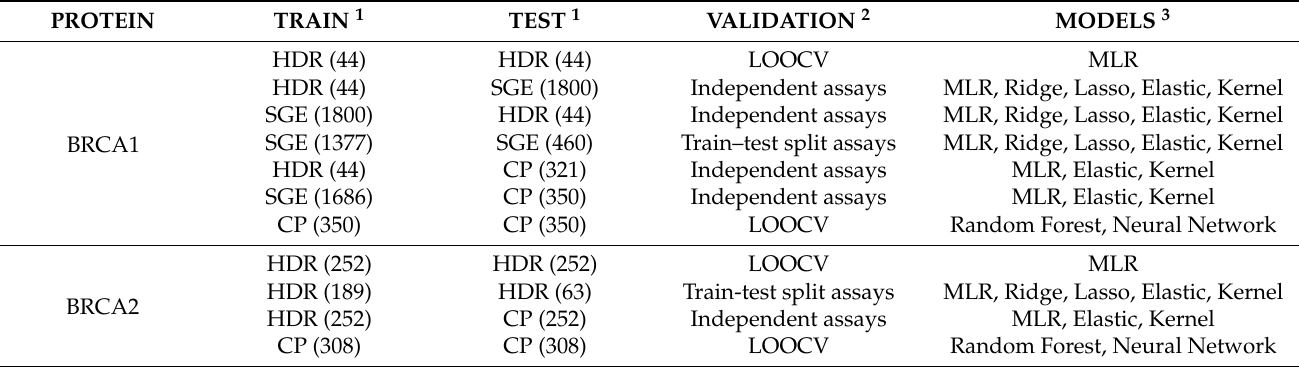
Figure 1. The sets of BRCA1/2 variants used in this work. The figure shows, for ( a ) BRCA1 and ( b ) BRCA2, the distributions of the variants for the Homology-Directed Repair (HDR, pink), Saturation Genome Editing (SGE, blue) and Clinical Phenotype (CP, orange) datasets along the sequence of these proteins. Functional domains are shown using rectangular boxes. We can see that, for both proteins, the variants with known endophenotype values (i.e., results of the functional assays HDR and SGE) concentrate at the N- and C-terminal domains. On the contrary, those variants of known pathogenic nature (benign/pathogenic; CP dataset) are distributed along the whole sequence. For those cases for which it was possible, we also showed the location of the variants in the three-dimensional structures available (BRCA1, PDB codes: 1jm7 and 1t15; BRCA2, PDB code: 1iyj). Table 1. Description of the training/test combinations used to develop the regression and pathogenicity prediction models in this work.